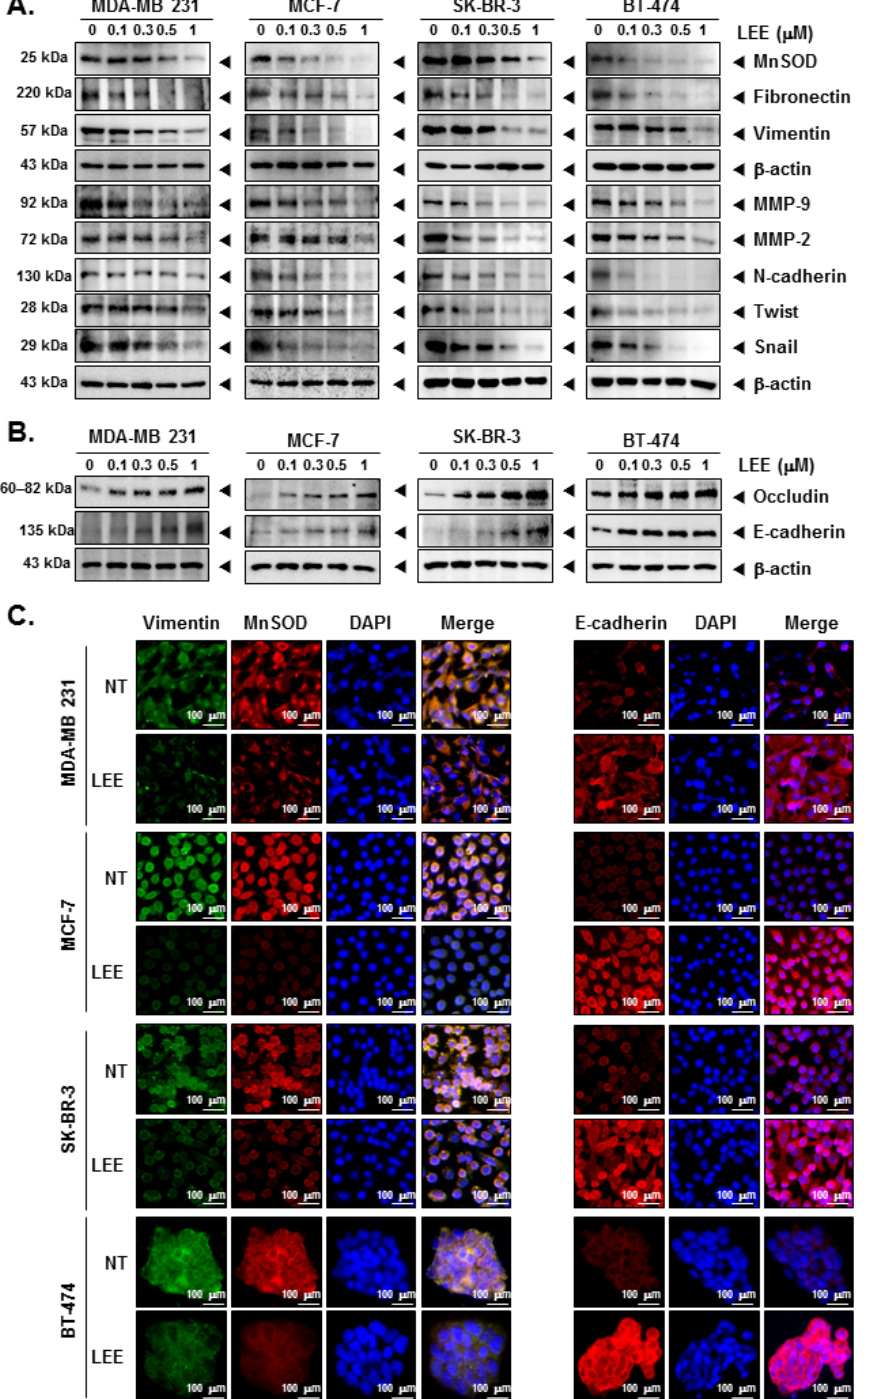
Figure 3. Regulation of EMT process by LEE in human breast cancer cells. ( A , B ) The expression of several EMT markers were analyzed by Western blot analysis in whole cell lysates. ( C ) Vimentin, MnSOD, and E-cadherin expression in the cells was observed by immunocytochemistry. DAPI was used to stain the nuclei in each cell. All the experiments were individually repeated at least thrice.